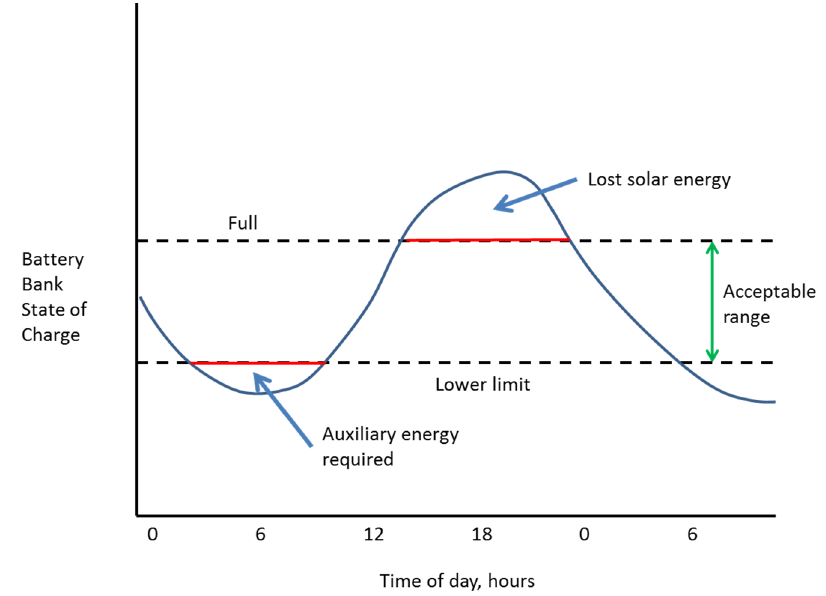
Figure 2. Typical daily variation in battery bank state of